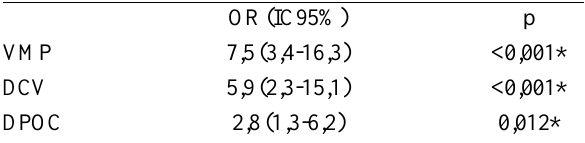
Tabela 3. Associação independente das variáveis com disfunção neurológica maior no pós-operatório de CRM isolada - análise